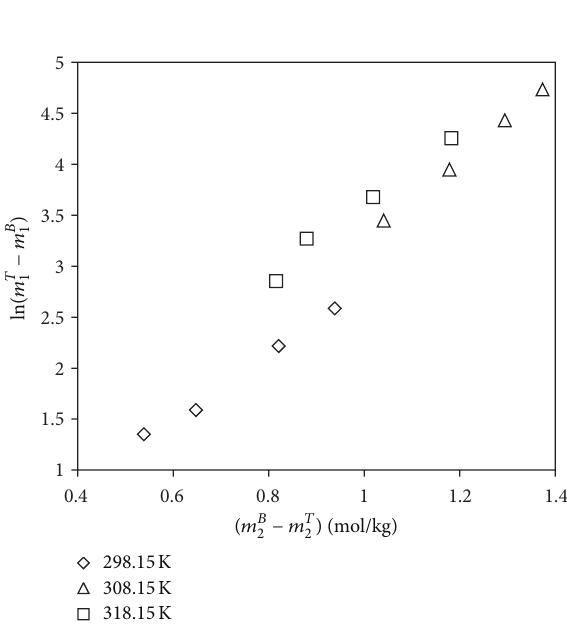
Figure 4: Setschenow-type plots for the type of salt on binodal curves for the PEG 6000 + sodium succinate + water systems for various